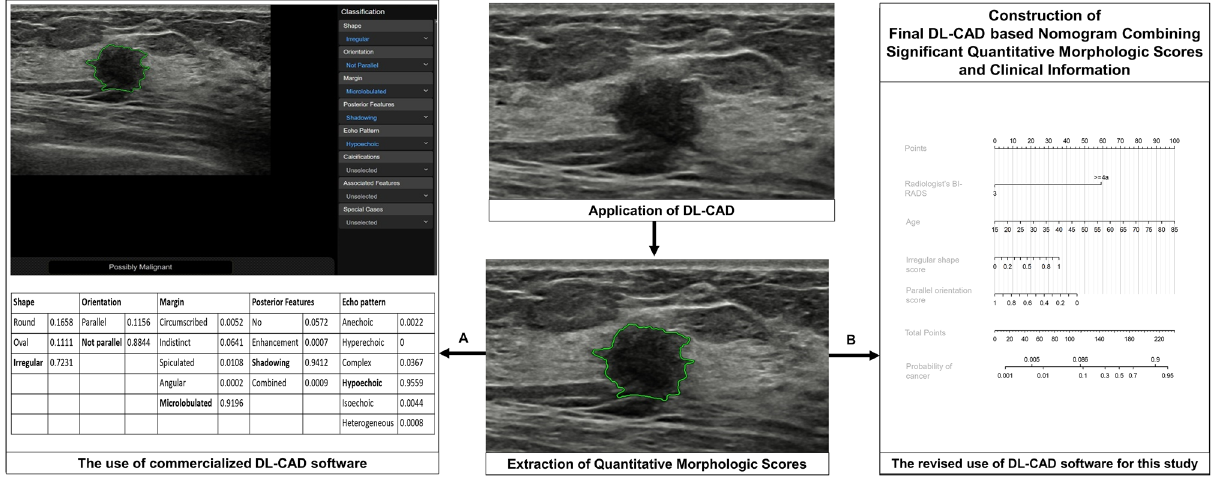
Figure 5. Application of deep learning based computer-aided diagnosis (DL-CAD) software in screening US-detected masses in ( a ) current commercialized mode and ( b ) our revised mode to build the diagnostic nomogram. A region of interest (ROI) (green line) was automatically drawn along the border of the screening US-detected mass in a 44-year-old woman, and the ROI based US features were analyzed by the DL-CAD software. Table in the left side shows quantitative scores obtained from DL-CAD software of the mass. The current commercial version of the DL-CAD software displays one descriptor with a maximum value for shape, orientation, margin, posterior echogenic features, and echo pattern: in this case, irregular shape, not parallel orientation, microlobulated margin, posterior shadowing, and hypoechoic echo pattern. Thus, these features and the final assessment of ‘possibly malignant’ were displayed on the monitor as an output ( a ). On the other hand, this study used the most significant quantitative morphologic scores extracted from the DL-CAD software and clinical information to build the diagnostic nomogram ( b